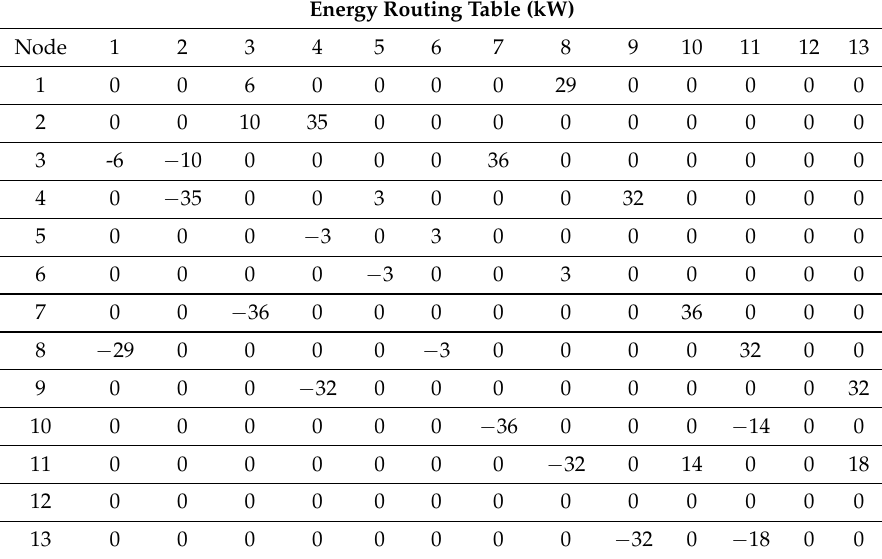
Figure 8. Cost comparison between the optimal method and GRASP on the NSFNET network. Table 1. Power assigned to the links of the NSFNET network by using the optimal method. Energy Routing Table (kW)